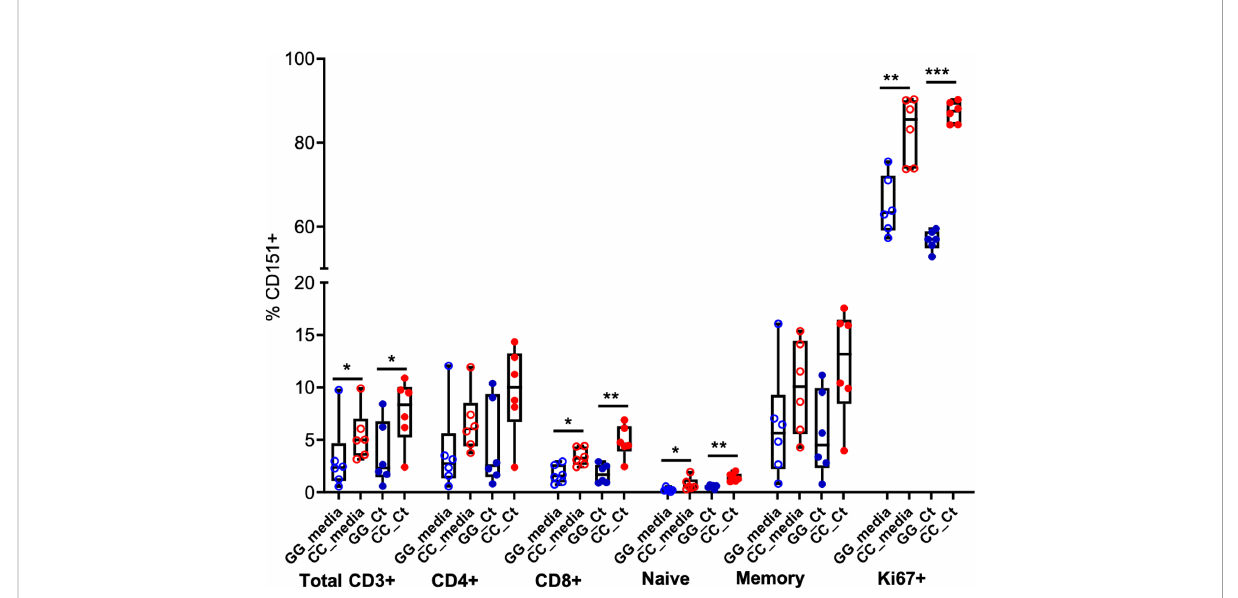
FIGURE 7 CD151 is enriched in memory and Ki67+ T cells. Box and whisker plots indicate frequencies of CD151+ cells among total CD3+ cells, CD4, CD8, naïve, memory and Ki67+ T cells in GG (n = 6; blue circles) and CC (n = 6; red circles) genotype groups, without (open circles) and with (closed circles) Ct stimulation for seven days. The boundaries of the box indicate the 25th and 75th percentiles; the line within the box indicates the median; whiskers indicate the 10th and 90th percentiles. Each dot represents one subject. The relative frequencies of CD151+ lymphocytes were signi fi cantly increased in the CC group with and without Ct stimulation compared to GG group among total CD3+ cells, CD8, naïve and Ki67+ T cells by Wilcoxon Rank Sum Test. *:P < 0.05; **:P < 0.01; ***:P < 0.005. No statistical differences were detected between media and Ct-stimulated groups for any cell